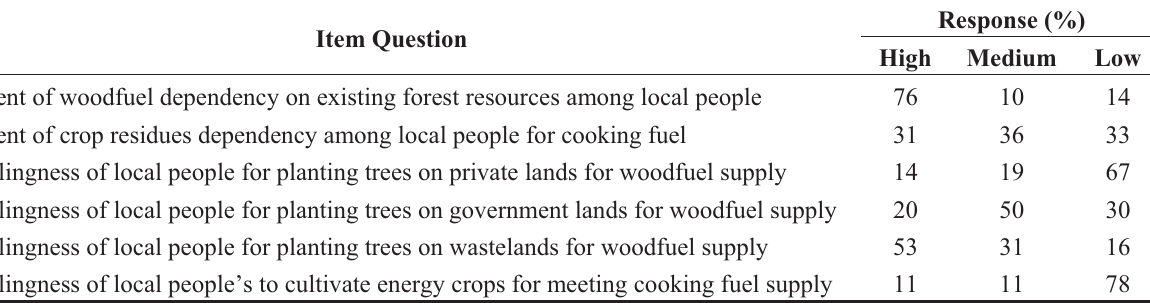
Table 6. Respondents’ perceptions on the dependency of local people on biomass resources and their willingness in planting